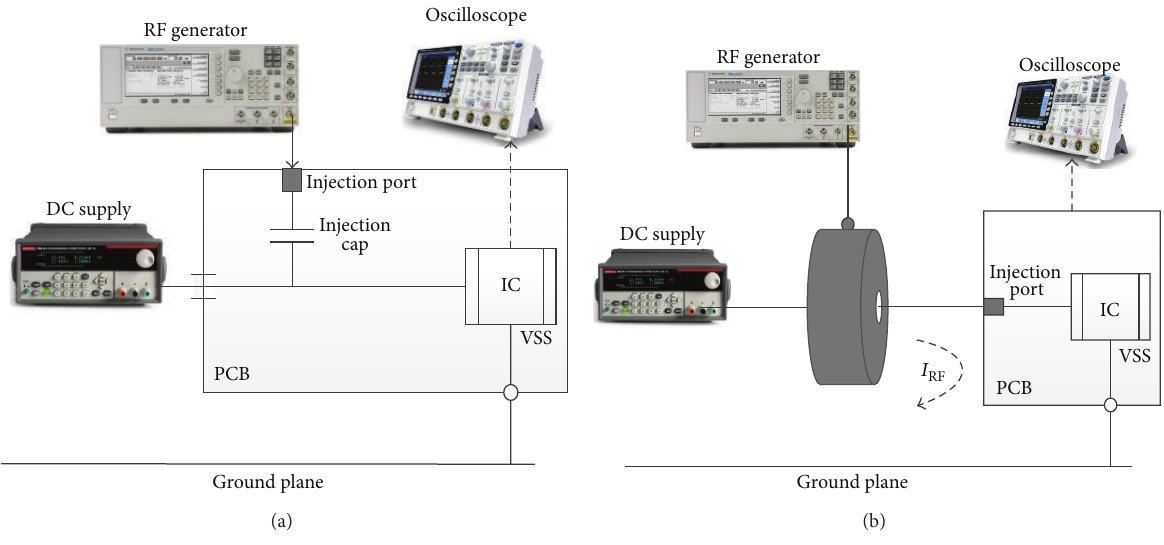
Figure 1: The concept of IC immunity test. (a) DPI test. (b) BCI